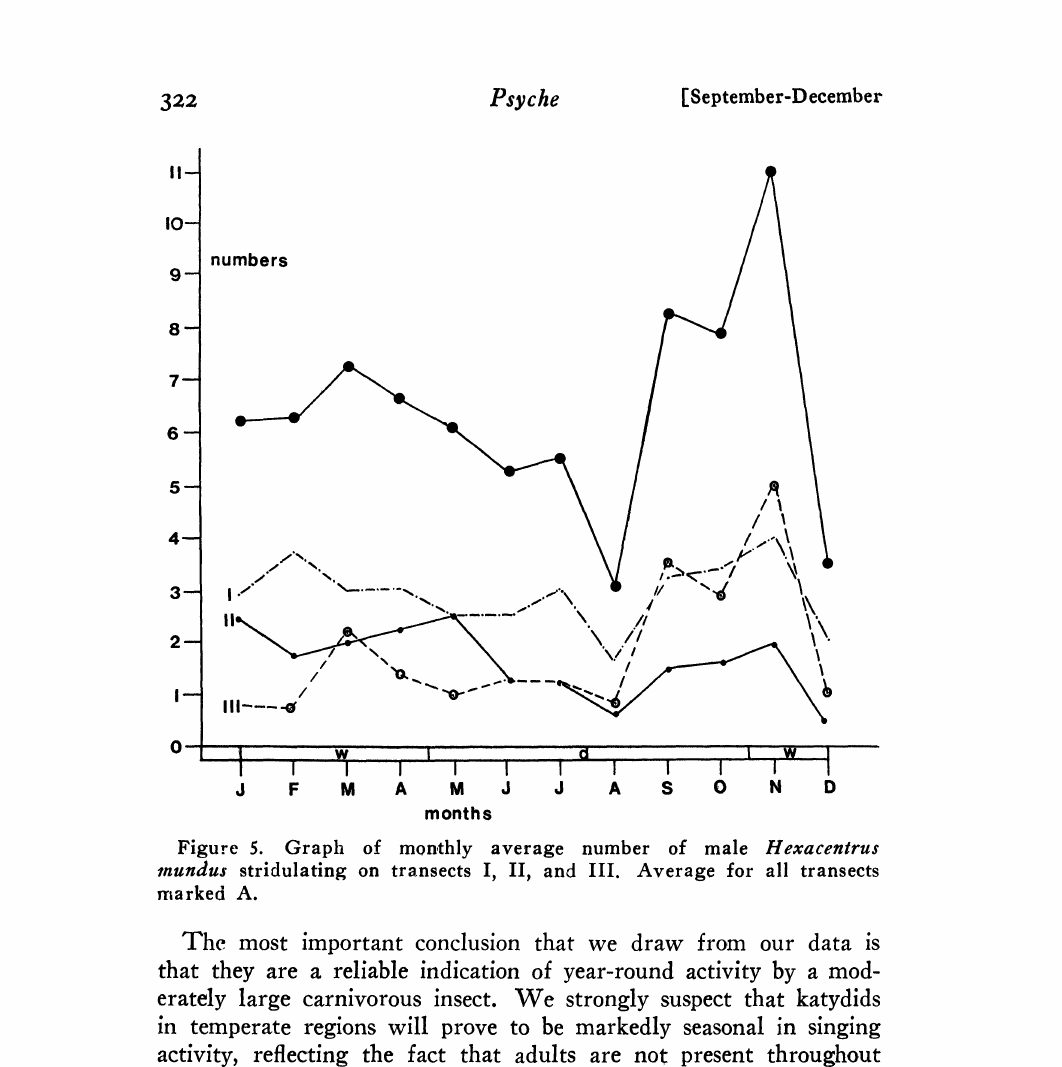
Figure 5. Graph o1: mon,thly average number ot: male Hexacentrus mundus stridulating on transects I, II, and III. Average 1:or all transects marked